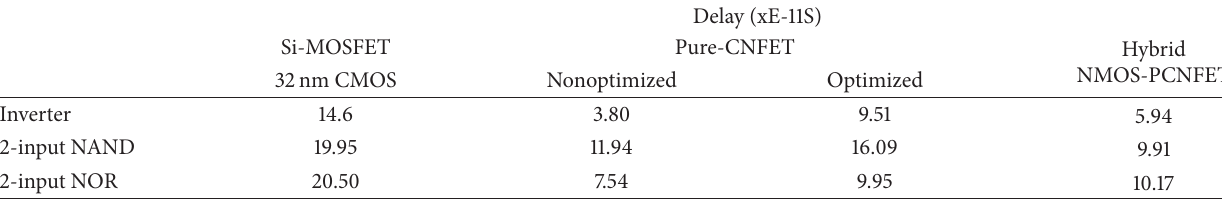
Table 4: The propagation delay of inverter, 2-input NAND, 2-input NOR gate for Si-MOS, pure-CNFET, and hybrid configuration.